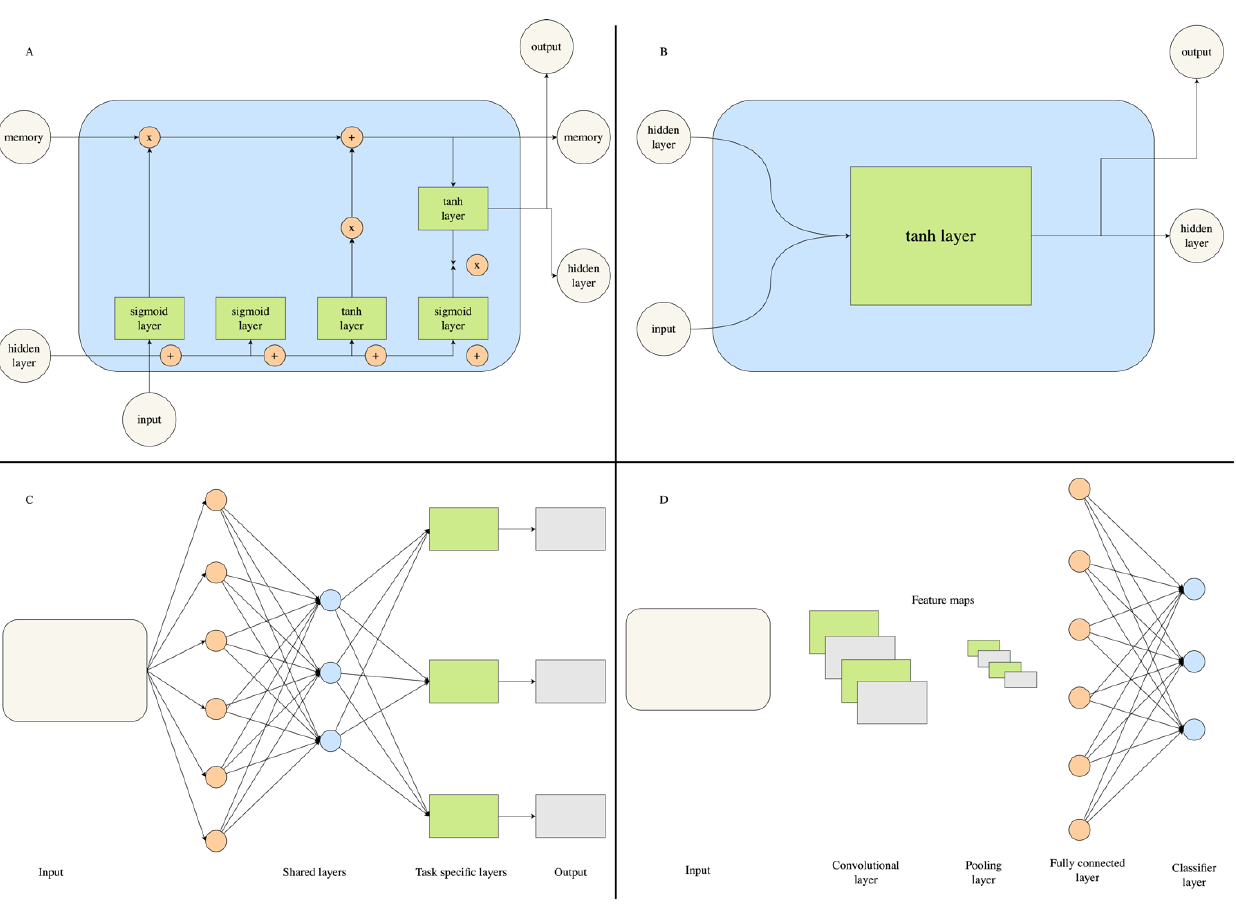
Figure 3. Workflows of LSTM ( a ), RNNs ( b ), multi-task learning ( c ) and CNNs ( d ).